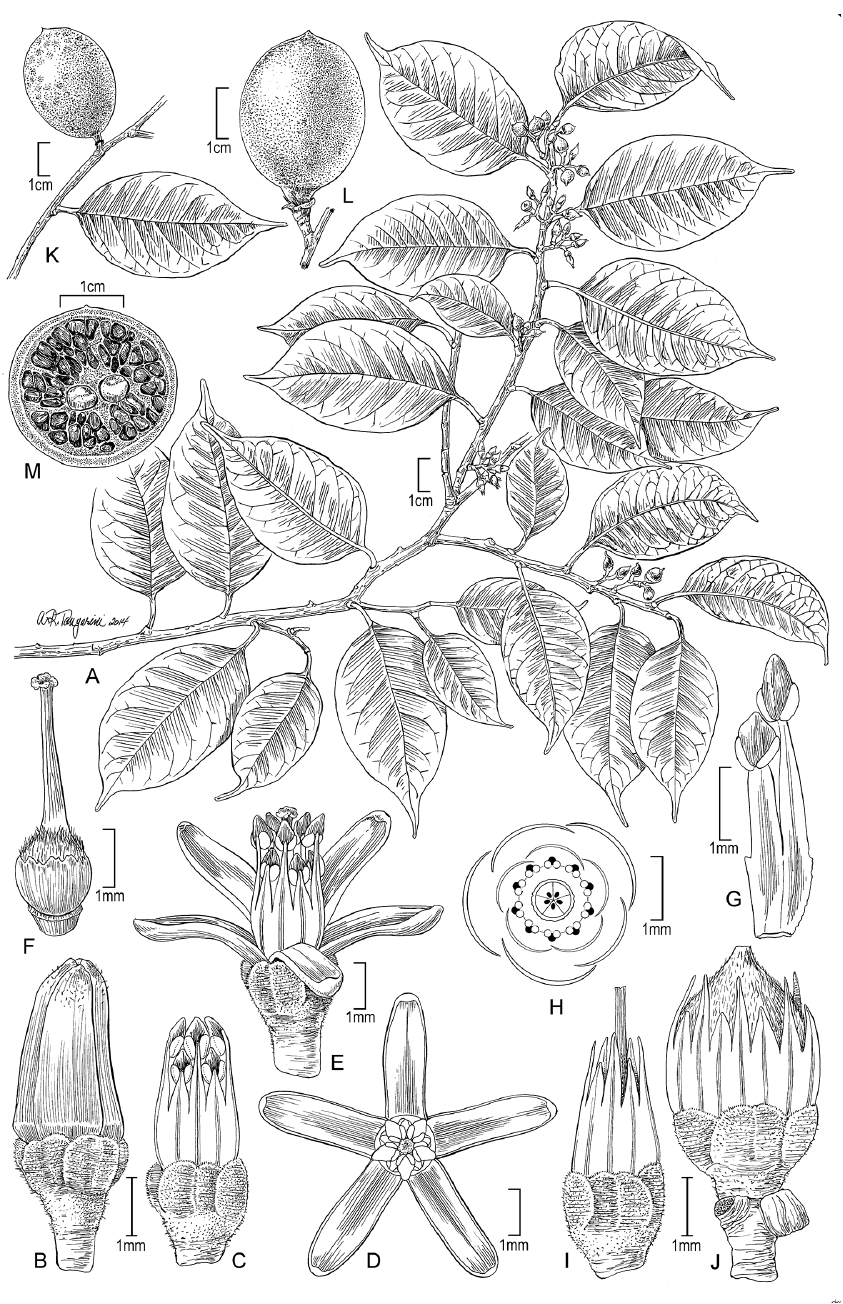
Figure 7 . Illustration of Sacoglottis perryi . A Habit B bud C bud with petals removed D open flower, axial E open flower, lateral F gynoecium G stamen cluster of 2 types, ventral H floral diagram I post- anthetic flower J young fruit K, L fruit M fruit with 2 central seeds and endocarp lacunae, transverse section. Source: A–M from specimens and life photos of Redden 7264